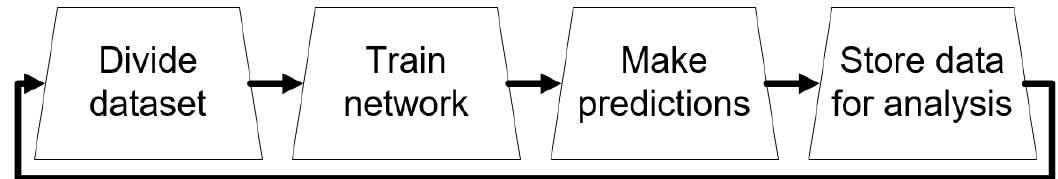
Figure 4. Training and prediction